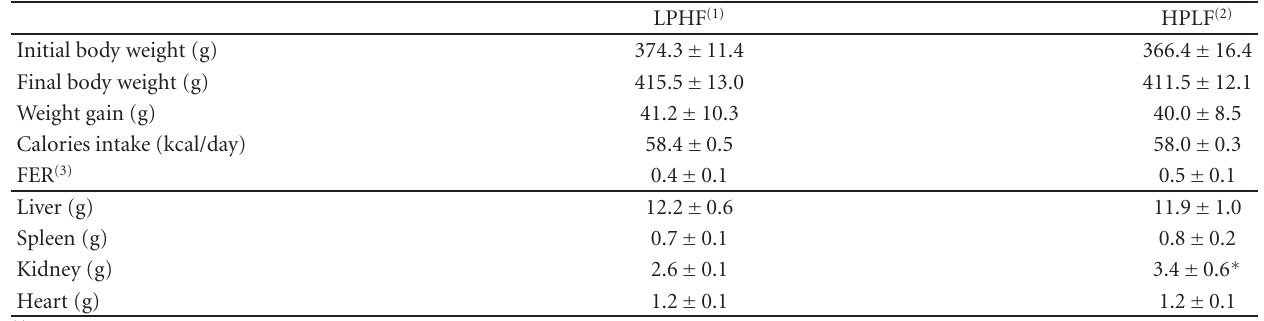
Table 1: Body weights, food intakes, FER, and organ